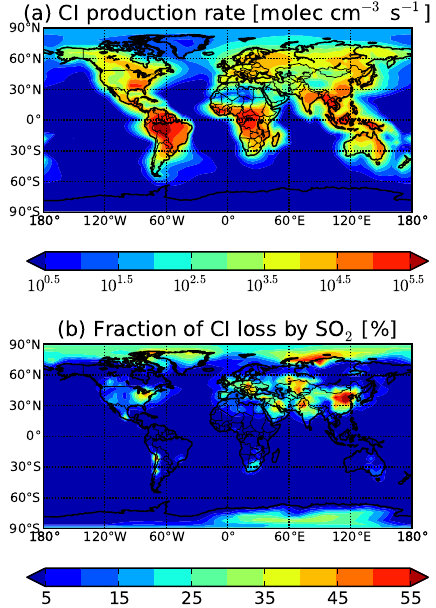
Fig. 1. (a) The annual-average boundary-layer production rate of CIs in the BBASE-CI (and XSOA-CI, same for both simulations) simulation. (b) The annual-average fraction of CI loss via reaction with SO 2 in the same simulation in the boundary layer.